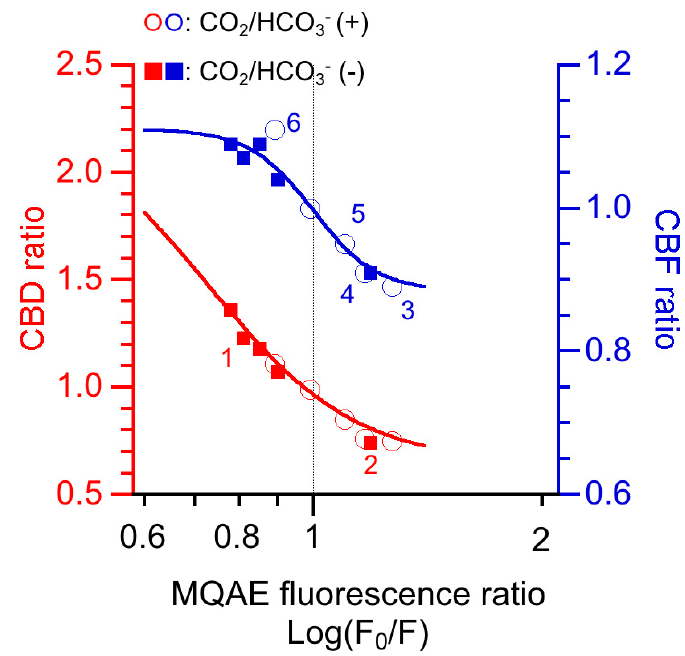
Figure 7. The effects of intracellular Cl − ([Cl − ] i ) on relative changes in the ciliary beat distance (CBD) and ciliary beat frequency (CBF) (CBD ratio and CBF ratio) in cHNECs. {Cl − } i s are monitored using the N-(ethoxycarbonylmethyl)-6-methoxyquinolinium bromide (MQAE) fluorescence ratio (F 0 / F). F 0 / F is an index of [Cl − ] i , not exact [Cl − ] i . In this figure, the F 0 / F, CBD ratios and CBF ratios have been published in previous experiments performed in both the presence and the absence of CO 2 / HCO 3 − [15,16,21]. The closed squares labelled 1 were obtained from the Cl − -free (NO 3 − ) solution experiments, and those labelled 2 were obtained from the 5-nitro-2-(3-phenylpropylamino)benzoic acid (NPPB) experiments. The open circles 3 and 4 were obtained from the NPPB and cystic fibrosis transmembrane conductance regulator inhibitor-172 experiments, respectively. The open circles 5 and 6 were obtained from the T16Ainh-A01 (a Ca 2 + -activated Cl − channel inhibitor) and the T16Ainh-A01 plus carbocisteine experiments, respectively. CBD was inhibited at a lower [Cl − ] i than CBF.